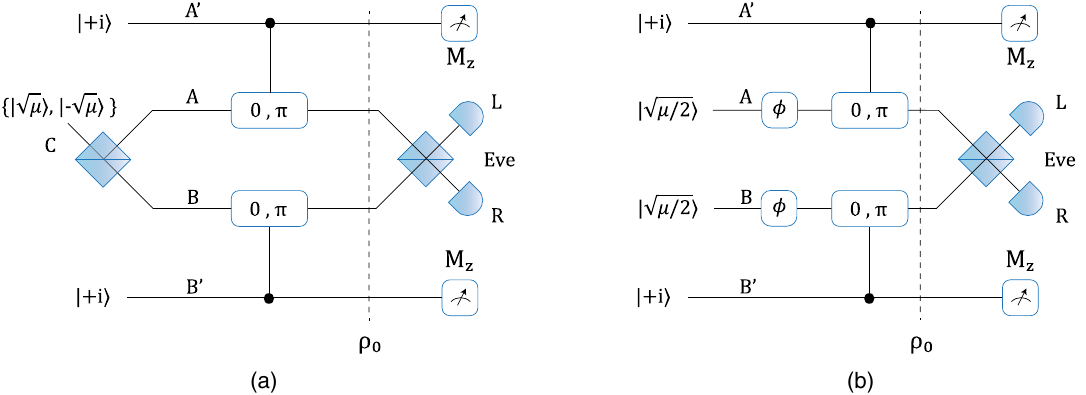
ffiffiffi ffiffiffiffiffiffi μ p i and j − μ p i with equal probabilities. (b) Schematic ffiffiffiffiffiffiffiffi p μ = 2 i and add the same random phase ϕ ∈ f 0 ; π g